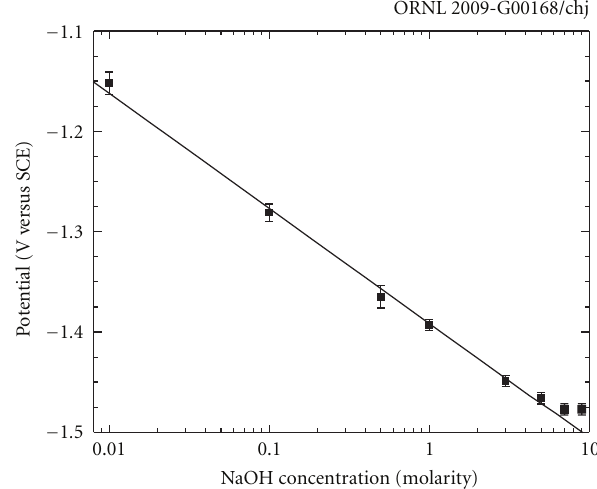
Figure 4: Peak potential as a function of the NaOH concentration in the electrolyte for ZnO electrode sample 4. The solid line is a least squares fit to the data points with a slope of 120 mV/decade, indicating a two-electron